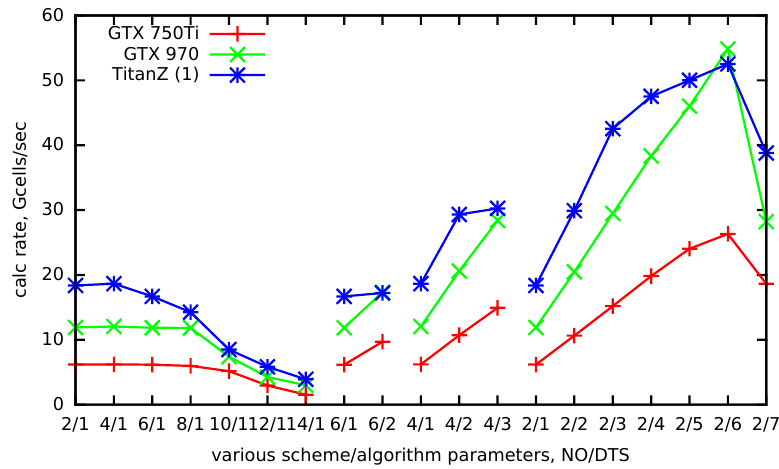
Figure 11. Performance results for different parameters. Horizontal axis labels are in the form N O / DTS